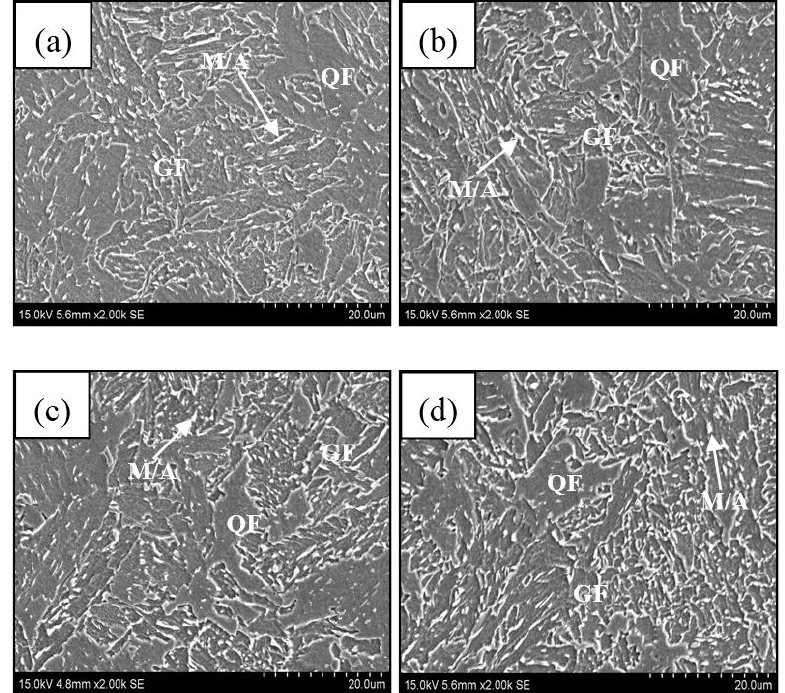
Figure 6. The SEM micrographs for the specimens with different finish rolling temperatures: ( a ) 850 °C; ( b ) 830 °C; ( c ) 810 °C and ( d ) 790 °C. QF—quasi polygonal ferrite, GF—granular bainitic ferrite and M/A—martensite/austenite.